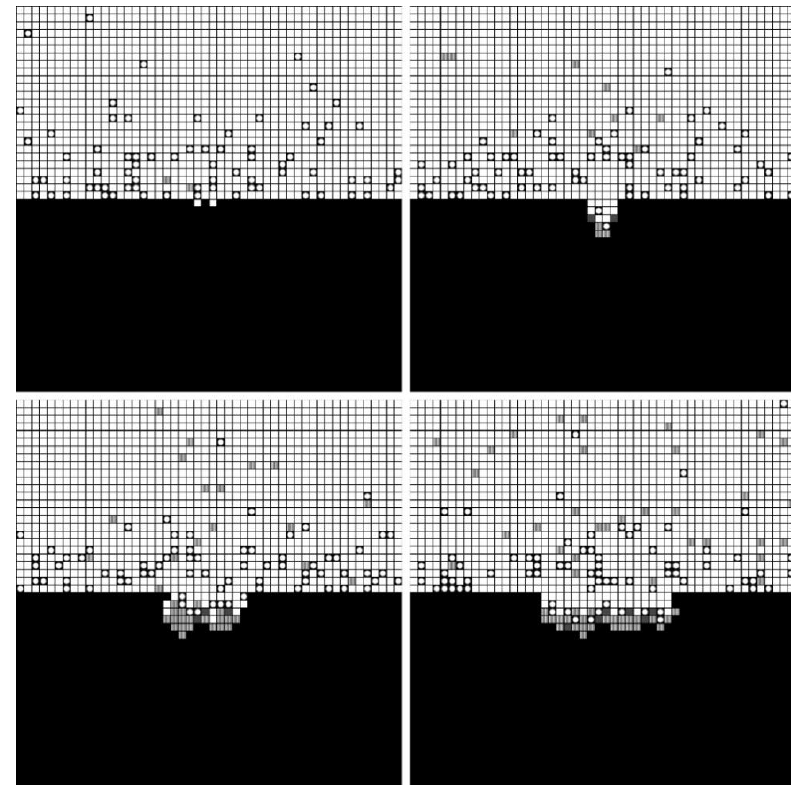
Figure 6. Simulation results under 6 V.